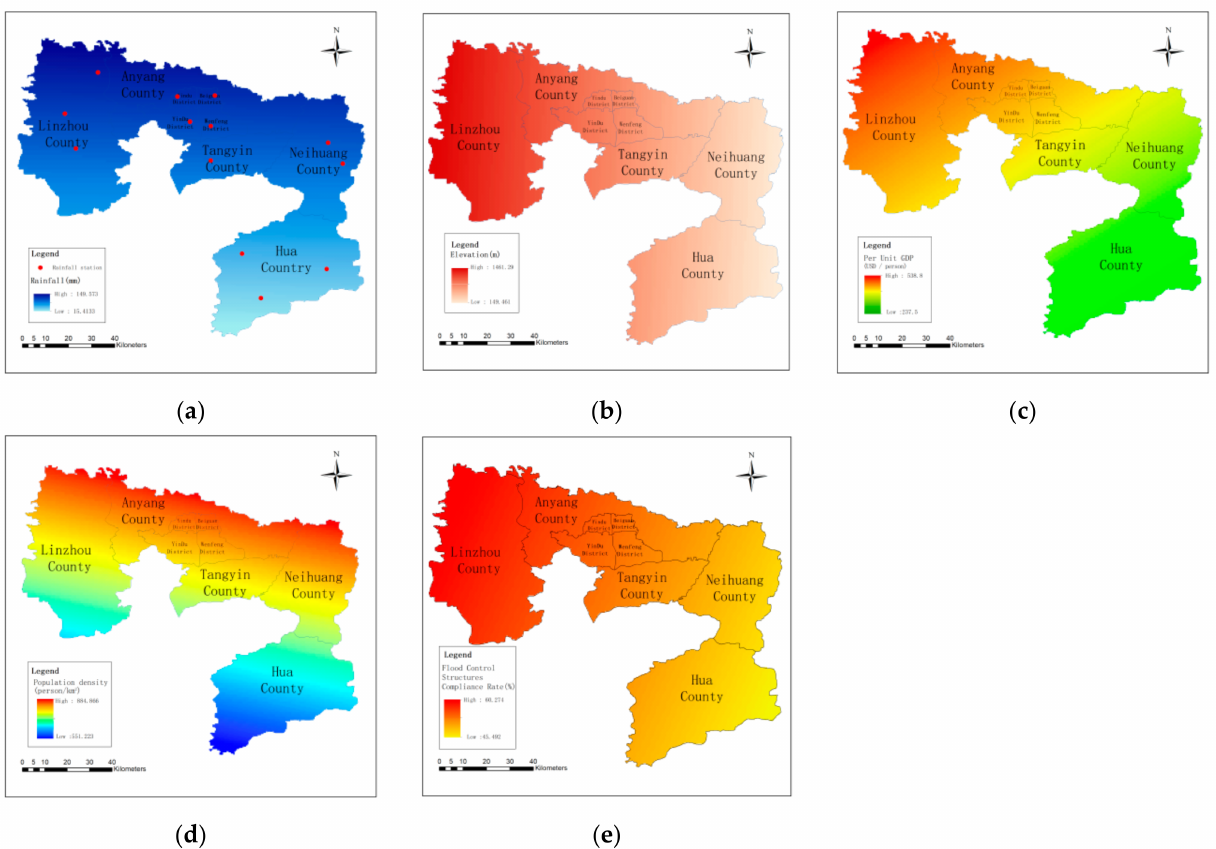
Figure 4. The collection and processing data related to flood disasters: ( a ) Monthly average precipitation (mm); ( b ) Elevation; ( c ) Per unit GDP; ( d ) Population density; ( e ) Flood control structures compliance